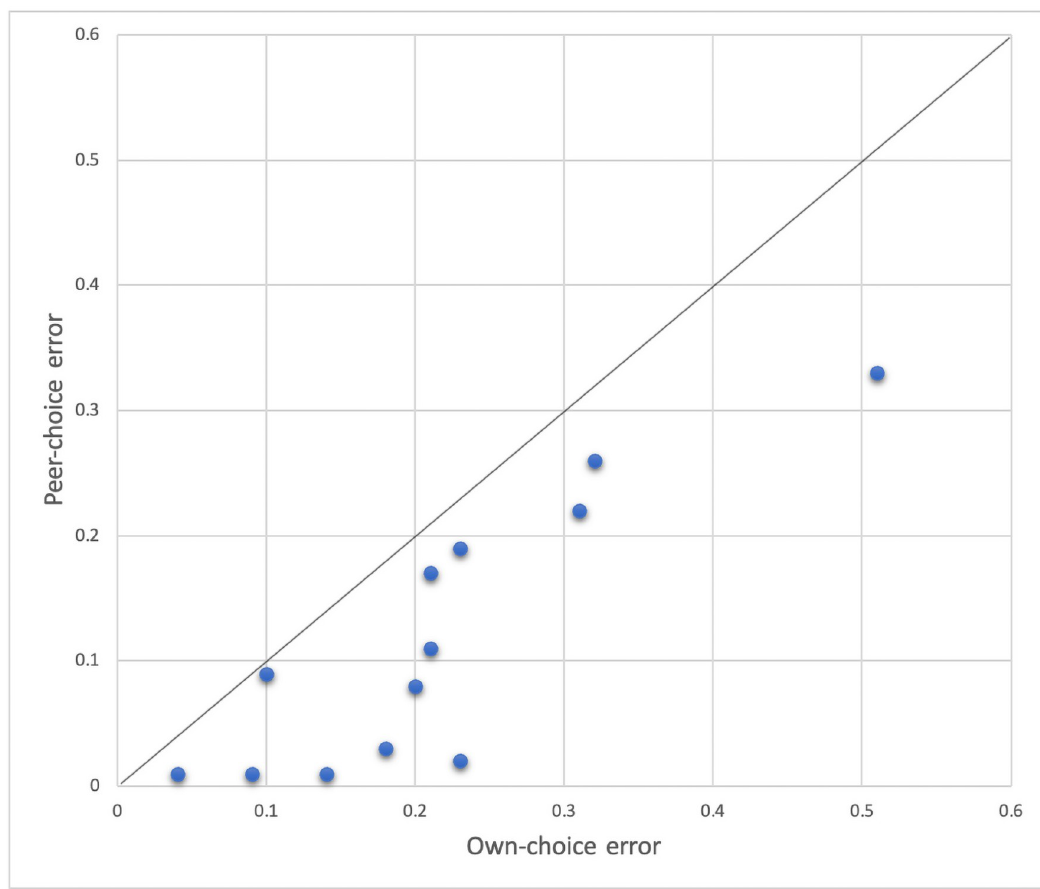
Fig 1. Comparison of the two matched errors: Peer-choice and own-choice in Experiments 1, 2, and 3.